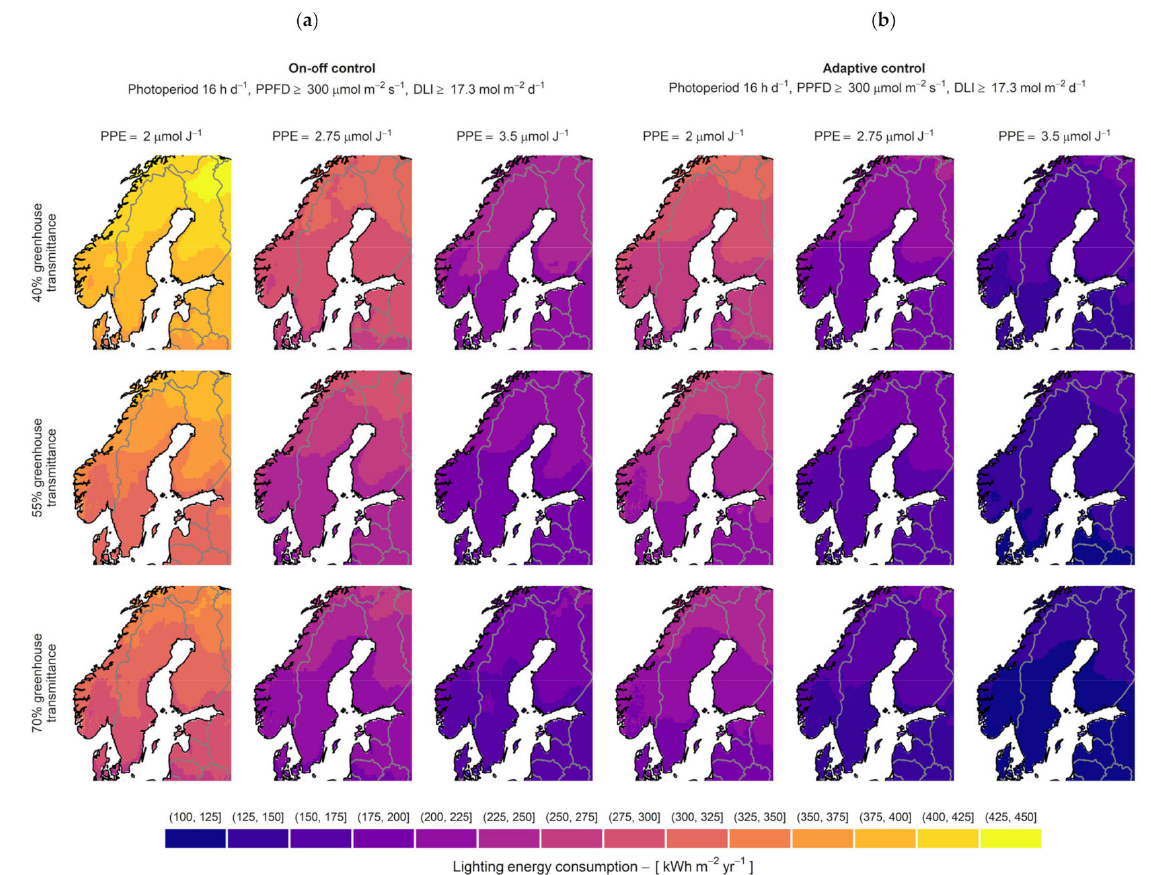
Figure 7. Yearly lighting energy consumption (E el, lamps , kWh · m − 2 · yr − 1 ) maps of the Nordic and Baltic countries for the chosen greenhouse cultivation period of 181 days: from 1 February to 20 May and from 20 August to 31 October. The electric energy demand of the lamps was calculated for a photoperiod of 16 h · d − 1 with a PPFD threshold of 300 µ mol · m − 2 · s − 1 , considering three different photosynthetic photon efficacies (PPE: 2, 2.75 or 3.5 µ mol · J − 1 ) and three possible greenhouse hemispherical transmittances ( τ h, PAR : 40%, 55% or 70%). The two panels compare different lighting control protocols: ( a ) On-off control vs. ( b ) Adaptive control. Values presented as a 0.1 ◦ × 0.1 ◦ grid both in latitude and longitude, extending from 54.5 ◦ N to 70 ◦ N in latitude and 4.5 ◦ E to 31.5 ◦ E in